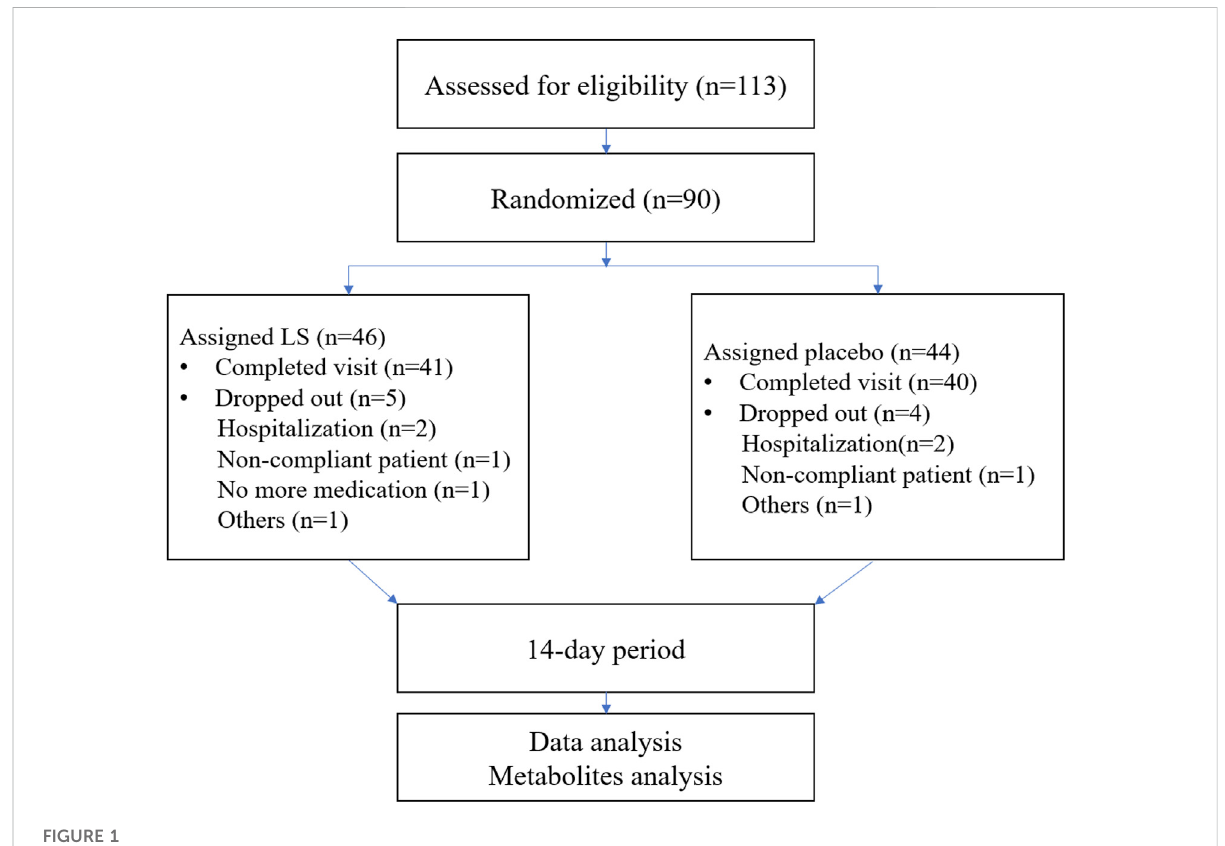
FIGURE 1 Schematic view of participant fl